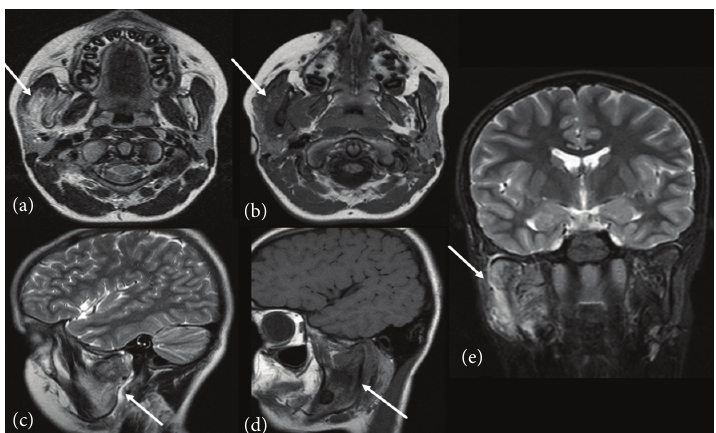
Figure 1: (a) T2-weighted axial 3 mm spin-echo sequences. (b) T1-weighted axial 3mm spin-echo sequences. (c) T2-weighted sagittal 4mm turbospin-echo sequences. (d) T1-weighted sagittal 3mm turbospin-echo sequences. (e) T2-weighted coronal 4mm turboinversion recovery magnitude sequences. (a)–(e) MRI sequences reveal enlarged mandibular bone structures with a loss of regular bony cortex and a soft tissue mass infiltrating the temporal and masseter